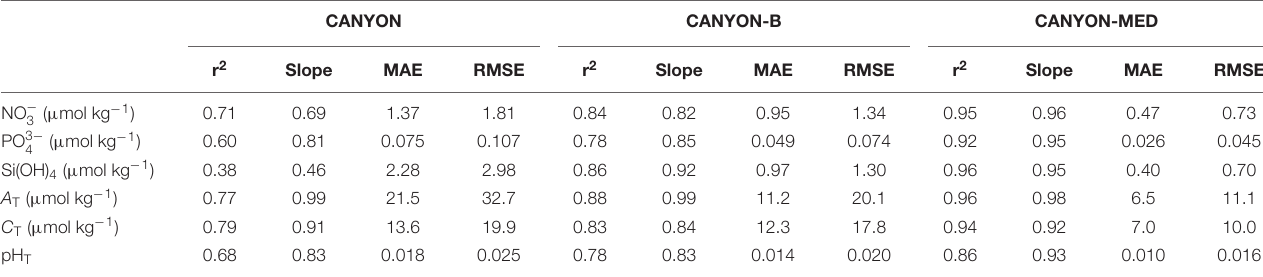
TABLE 4 | Statistics between the CANYON, CANYON-B, and CANYON-MED -retrieved values with the corresponding in situ measurements applied on the entire database for NO − 3 , PO 3 − 4 , Si(OH) 4 , A T , C T and pH T .